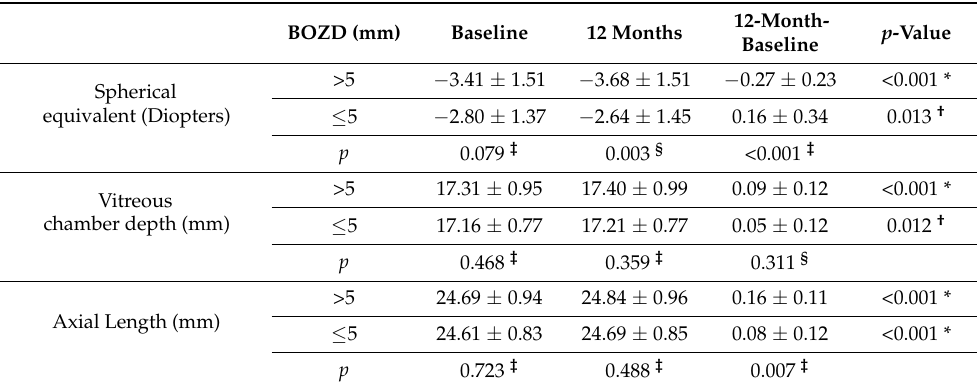
Table 2. Changes from baseline to 12-months treatment in the BOZD group: >5 mm (L-BOZD, n = 36) and ≤ 5 mm (S-BOZD, n = 35). BOZD